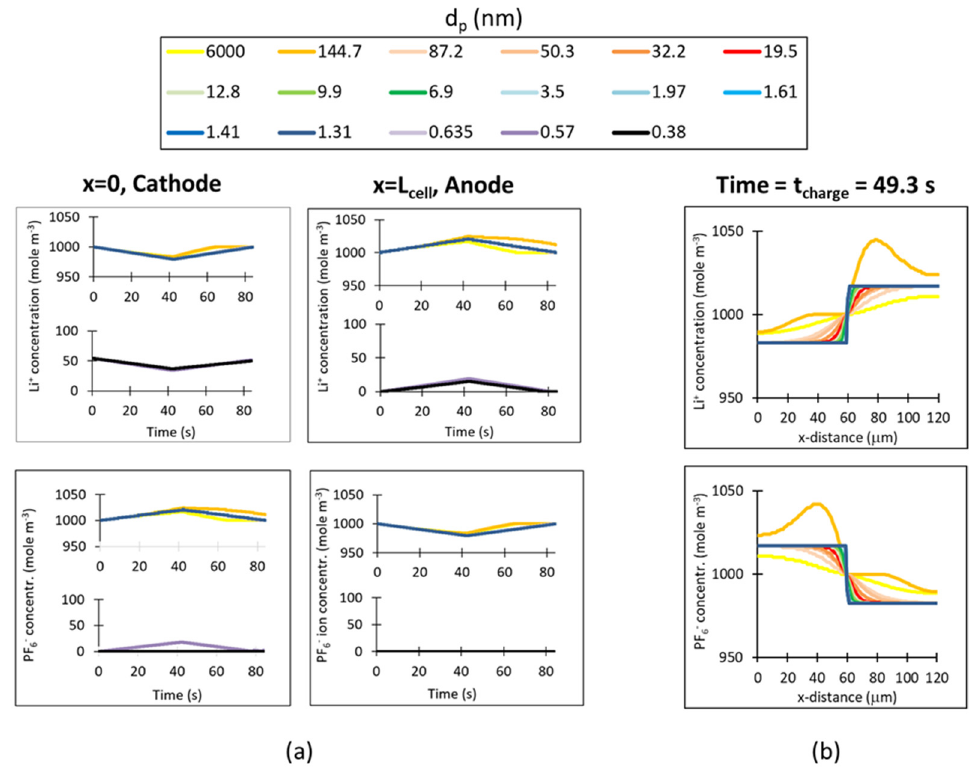
Figure 8. Ion concentration in different pore sizes from the electrode PSD, predicted by the computer simulation of the GCD cycle of the xGNP-750 EDLC with electrolyte 1M LiPF 6 in EC:DMC; ( a ) ion concentration evolution during charge and discharge, at x = 0 (in the cathode by the current collector) and at x = L cell (in the anode by the current collector); ( b ) ion concentration profiles at the end of charge, from x = 0 through the cathode and anode to x = L cell .